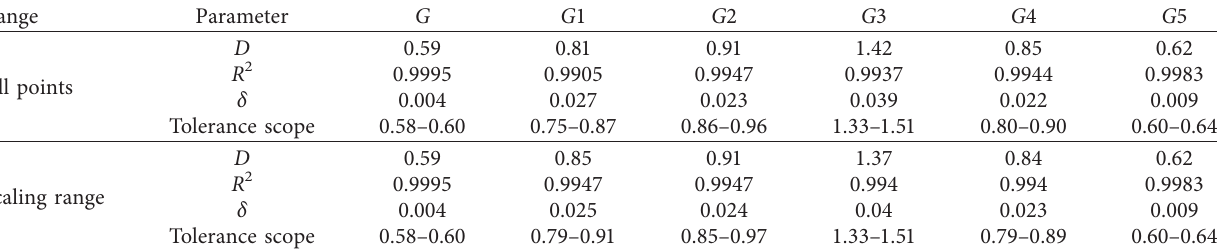
Table 2: Fractal dimension results and confidence statements of various types of green space calculated by using the grid dimension. Range Parameter All